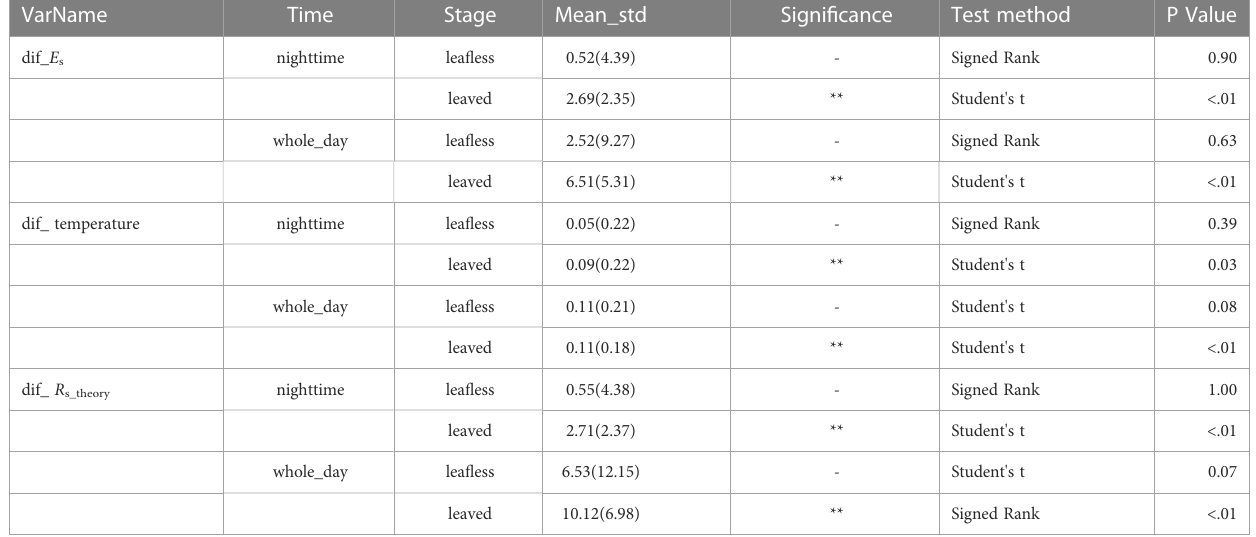
TABLE 1 The difference in measured ef fl ux (dif_ E s ), stem surface temperature (dif_ temperature), and theoretical respired ef fl ux (dif_ R s_theory ) between transparent and light-proof chambers.